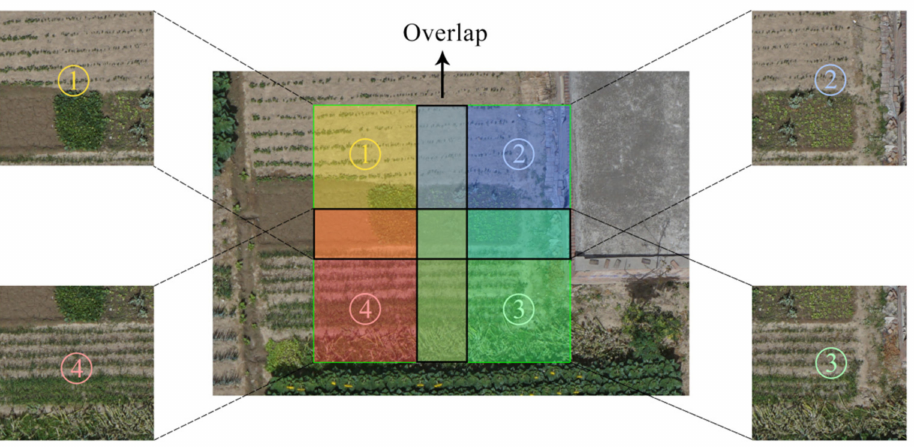
Figure 3. Image segmentation with